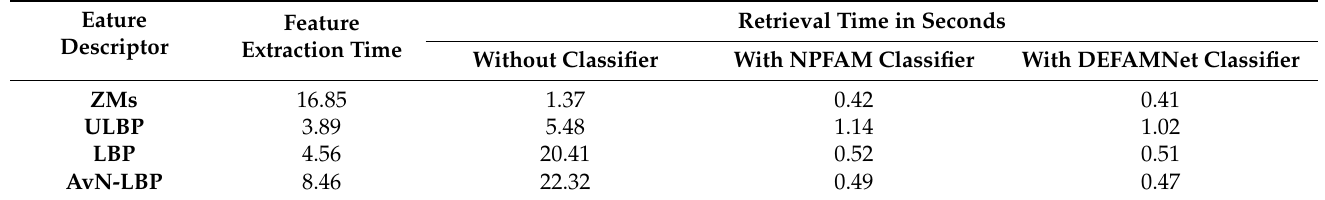
Table 8. Feature extraction and retrieval time in secs over OASIS–MRI databases using proposed LBP/VAR and other descriptors considered for comparison.